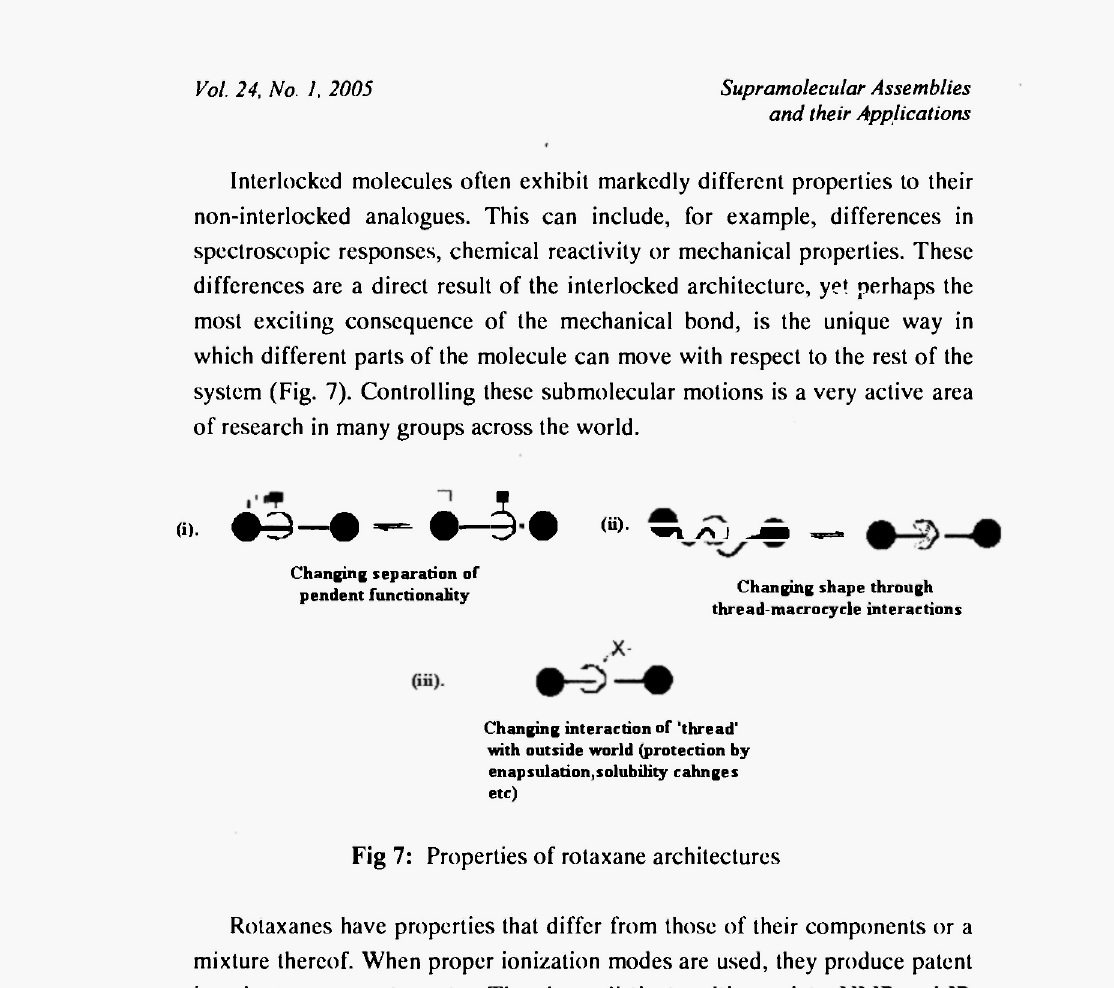
Fig 7: Properties of rotaxane